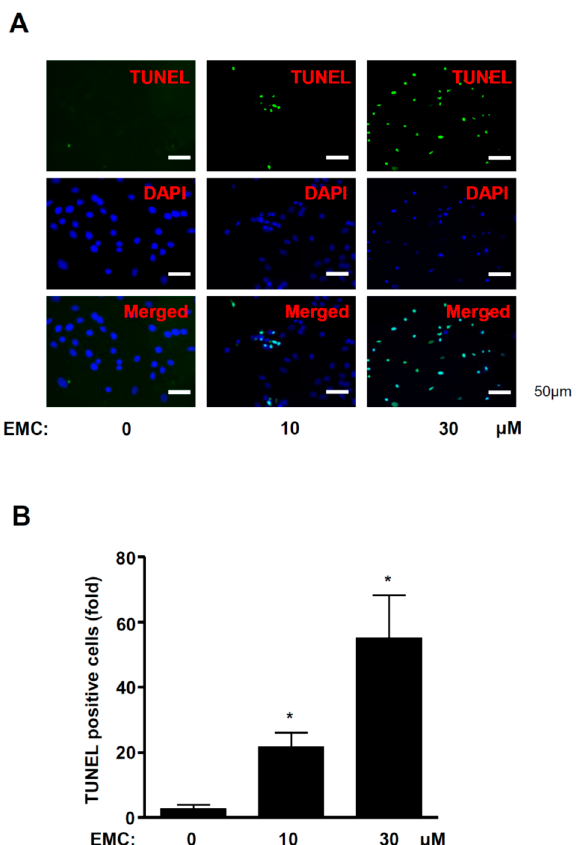
Figure 4. EMC increases DNA fragmentation in pre-osteoblasts. ( A ) DNA fragmentation was stained by TUNEL reaction (green) and DAPI (blue) solution at 24 h after EMC in pre-osteoblasts and observed by a confocal microscope. (B) The total number of cells in a given area was determined by DAPI staining. For quantification, three randomly selected areas were assessed. Scale bar: 50 µ m. The results are representative of three independent experiments. The data are expressed as the mean ± S.E.M. of experiments. * ( p < 0.05) indicates statistically significant differences compared to the control.